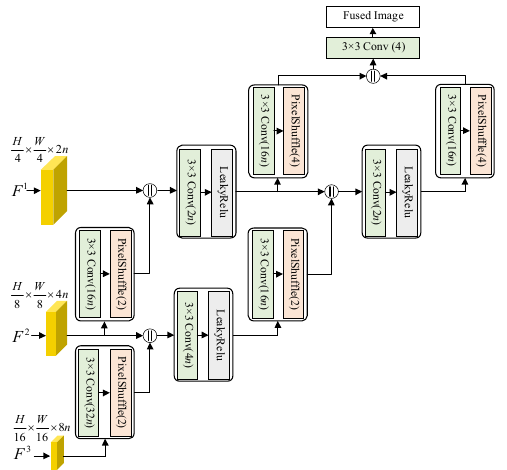
Figure 4. The architecture of MRM.